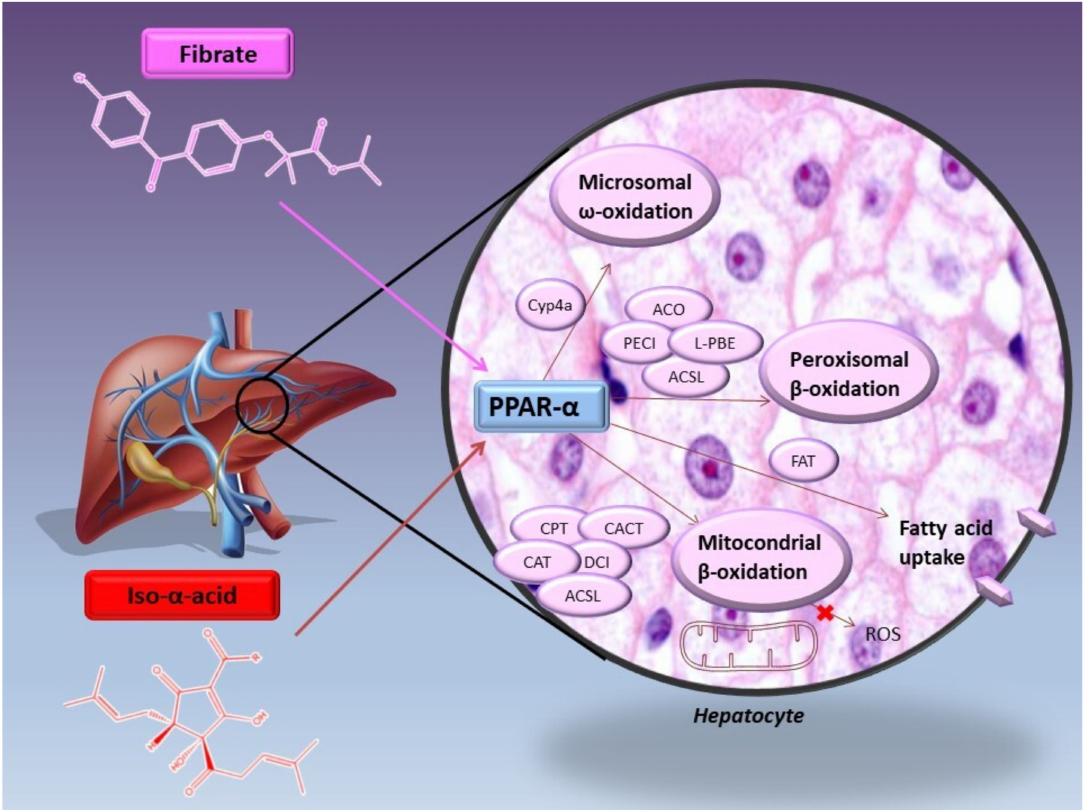
Figure 8. Iso - α -acids as well as Fibrate decrease fatty acid and triglycerides plasma levels by up-regulating genes involved in fatty acid up-take, microsomal ω -oxidation, peroxisomal and mitochondrial β -oxidation. These activities exerted by bitter hop compound are related to the activation of PPAR- α with a mechanism very similar to that of